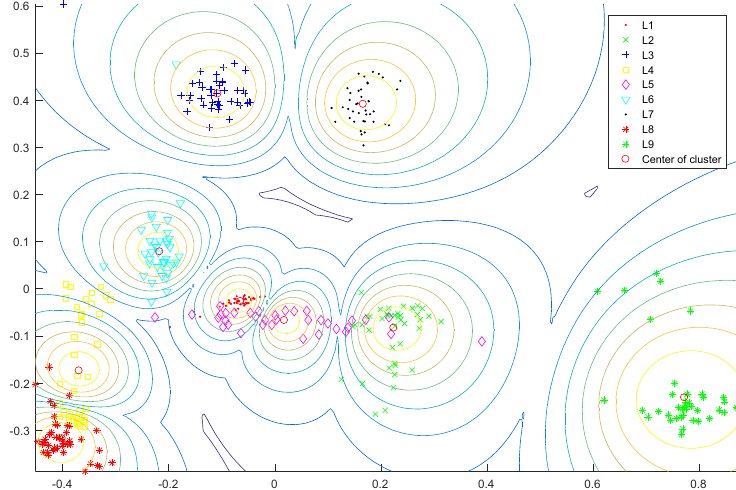
Figure 8. 2D projection of the training samples (0.5 labeled).